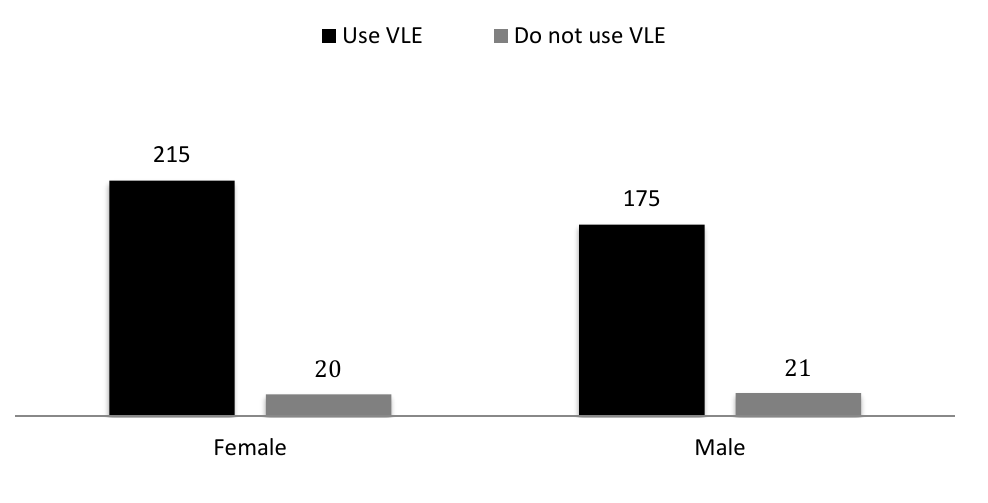
Figure 1: Respondent use and non-use of the VLE according to role Respondents were asked to indicate gender, however gender bias was evident (Figure 2).